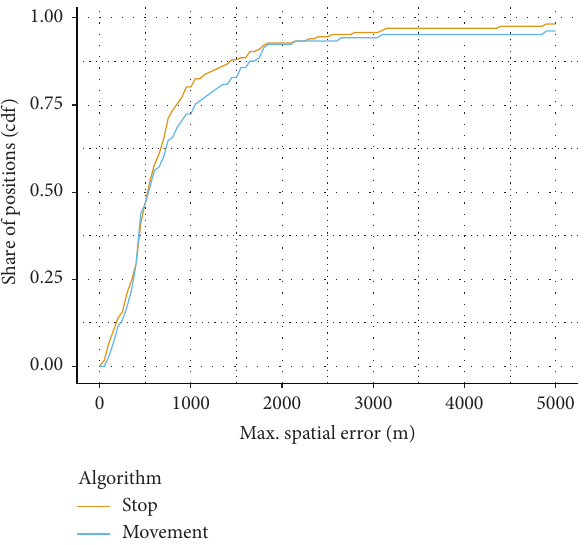
Figure 9: Spatial error at the start and end of trips. For each Google trip, the distance at the start and end positions is calculated to the cellular trip that matches best in time. Google trips without a cellular trip that matches in time (start and end within ± 45min) are not included.